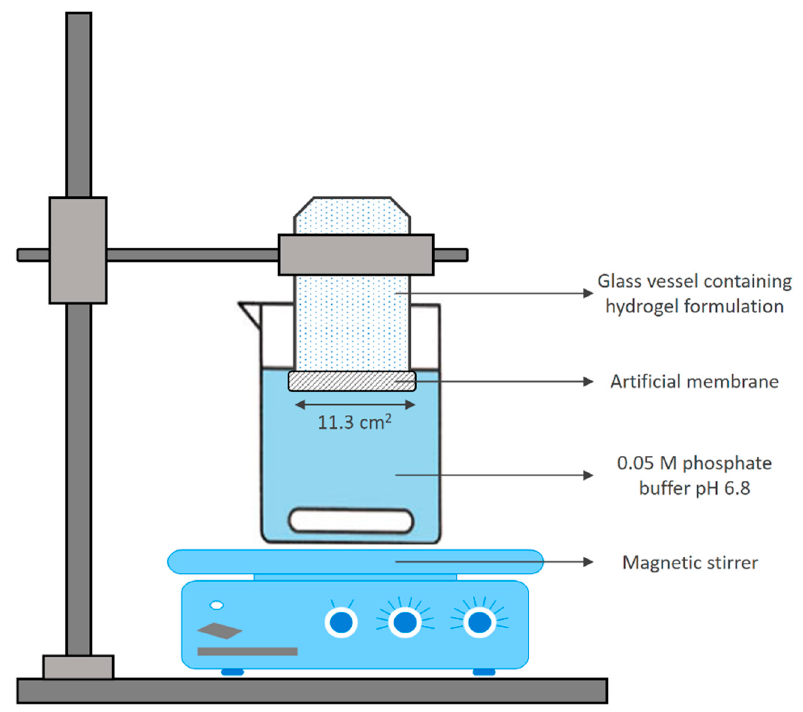
Figure 3. Schematic representation of in vitro drug release and permeation model. The amount of the drug permeated per unit surface area (µg/cm 2 ) was plotted versus time (hours). From the dissolution curves, the steady-state flux J ss (µg/cm 2 /h) was calculated for each formulation as the slope of the linear part of the curve (from 60th to 300th minute). The permeability coefficient (P m ) was then calculated according to the following equation [38]. P m = J ss /C d ; where P m is the permeability coefficient (cm/h), J ss is the steady-state flux, and C d is the concentration of the drug in the donor side, i.e., in gel formulations [39]. The enhancement factor (EF) was calculated as the ratio of the steady-state flux of the formulation containing the permeation enhancer and the steady-state flux of the corresponding control formulation without the permeation enhancer. Negative and positive controls were performed before the analysis of clindamycin hydrogel formulations. The blank formulations (without clindamycin, but with and without bile acids) were first tested, and no interferences were identified at 210 nm. In addition, the suitability of this method has been confirmed using low permeable and highly permeable drugs. 4.6. Structural Modelling and Geometry Optimization Initial 3D structures of clindamycin hydrochloride and bile acids (cholic acid and deoxycholic acid) were prepared using the Chem3D Ultra v. 16.0.1.4 program package. The initial 3D structure of clindamycin – bile acid complexes were constructed in the same way. Molecular geometries were optimized using MM2 force field calculations, as implemented in Chem3D Ultra software [40]. 4.7. Statistical Analysis